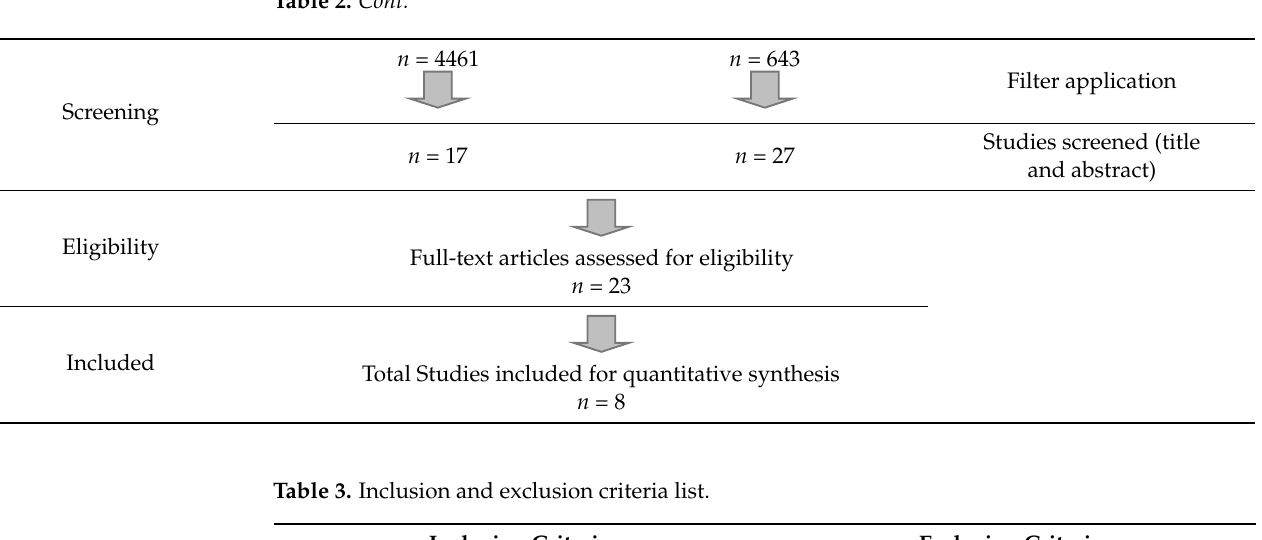
Table 2. Search strategy and results of identification, screening for eligibility, and inclusion of pub- lications considered for review.